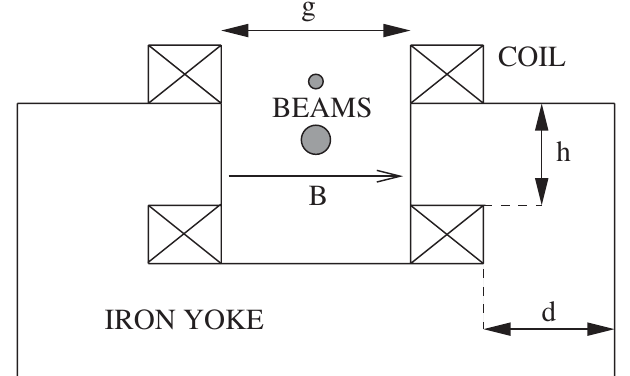
FIG. 13. Cross section of a C-type magnet, with the relevant parameters to be considered for its design. The disrupted beam passes between the poles, while beamstrahlung photons travel between the upper